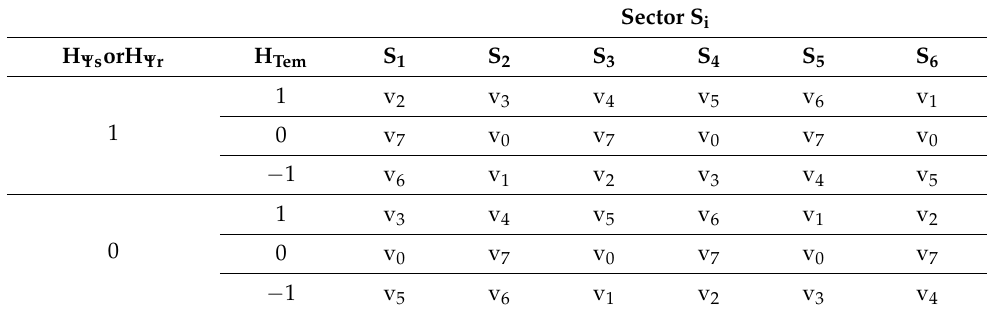
Table 1. Sequences of switching